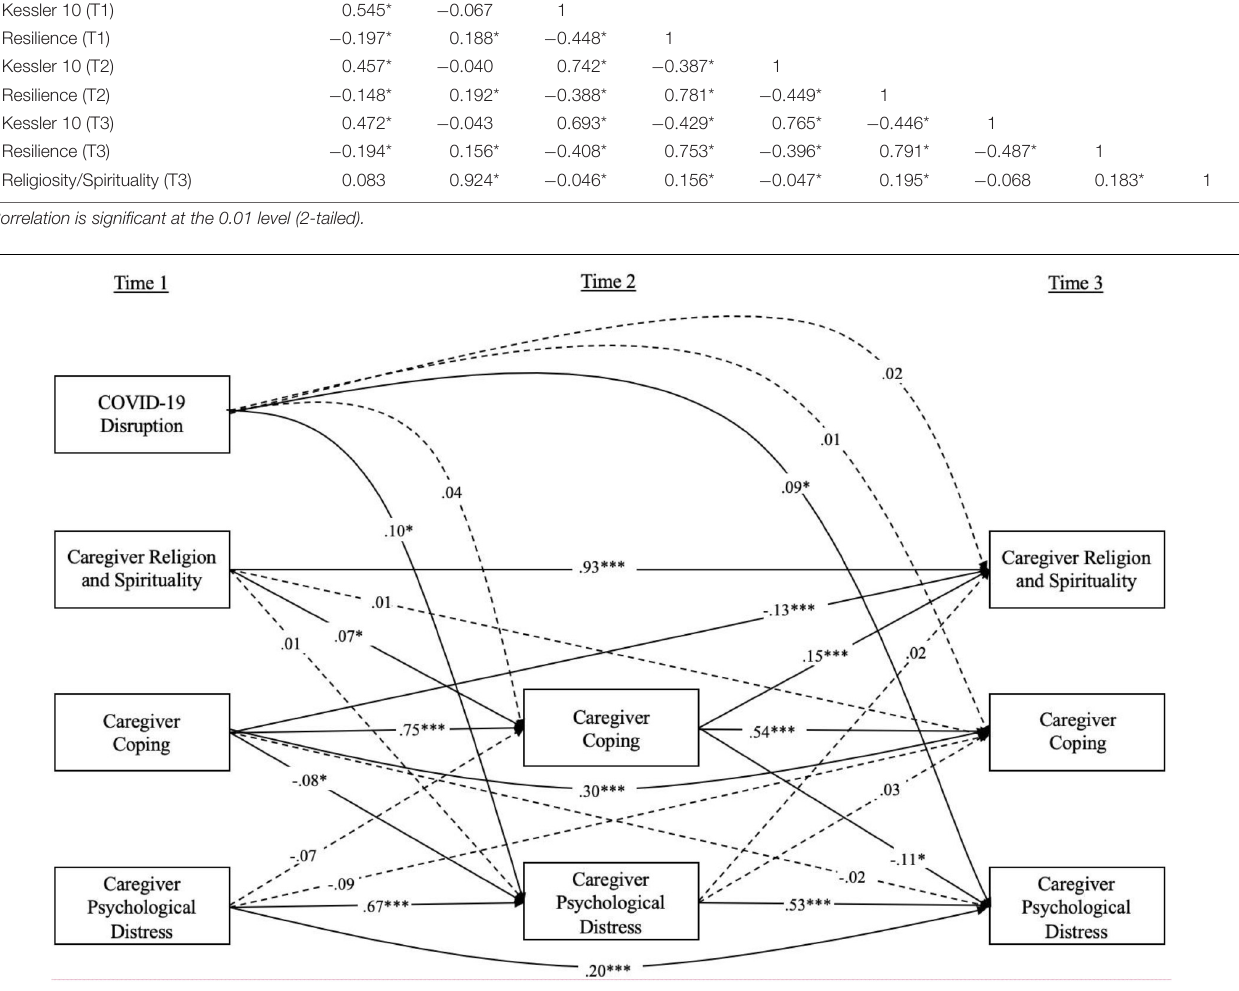
FIGURE 1 | Cross-lagged regression model examining the proposed mediation model of caregiver resilience mediating the relationship between caregiver R/S and caregiver psychological distress. Values shown are standardized coefficients. Solid lines indicate significant parameter estimates. Dotted lines indicate non-significant parameter estimates. * p < 0.05, *** p <